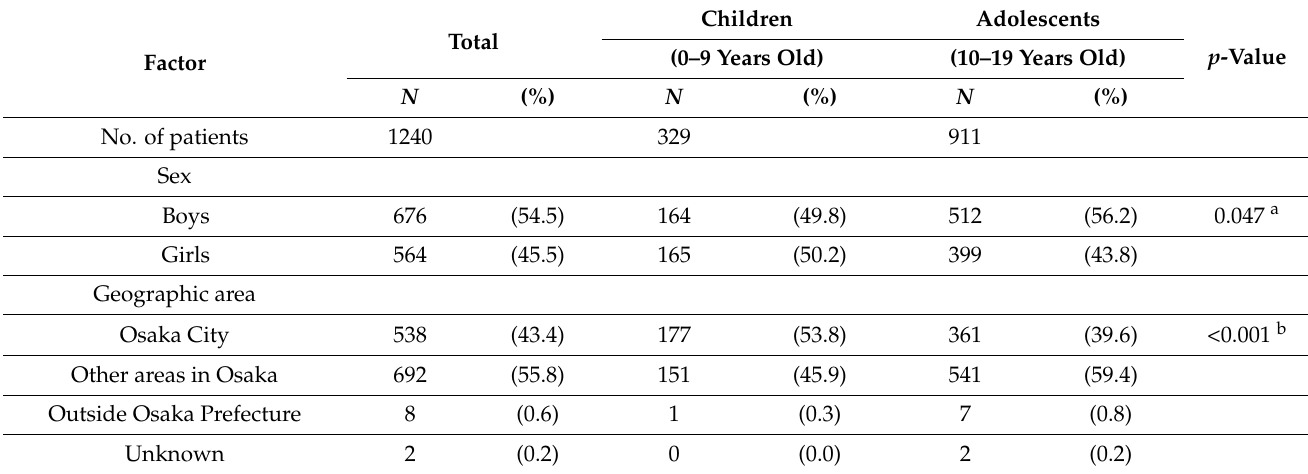
Table 1. Epidemiological characteristics of pediatric patients in Osaka Prefecture,